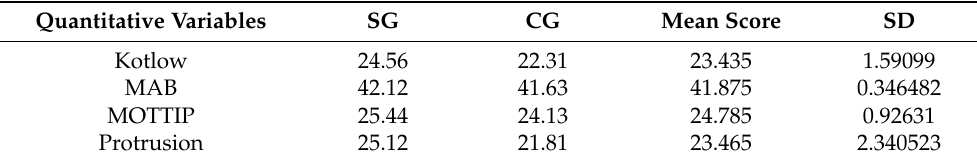
Table 7. Comparison between the SG and the CG at T1 in relation to the quantitative variables. Quantitative Variables